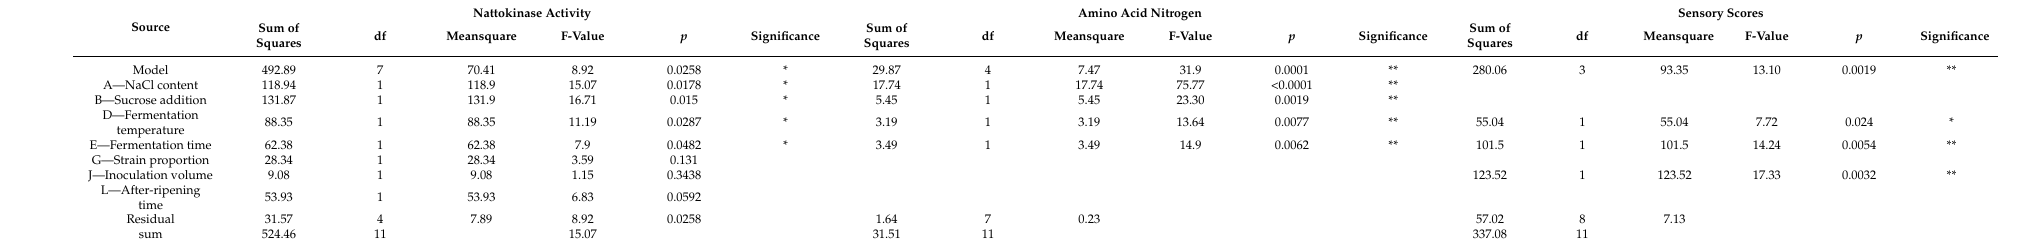
Table 3. Experimental analysis of variance-response values was based on nattokinase activity, amino acid nitrogen, and sensory